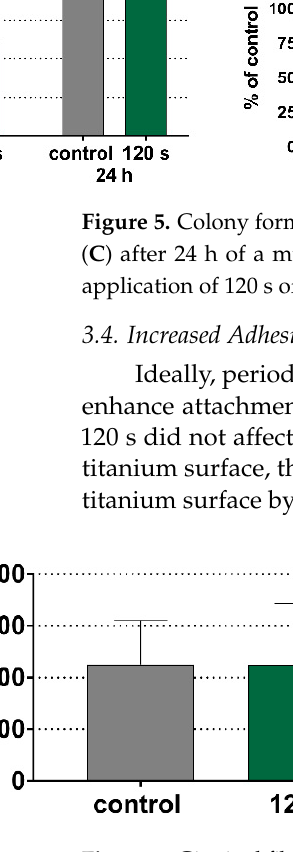
Figure 4. Colony forming units (CFU) counts ( A ) after 4 h and 24 h, mass ( B ), and metabolic activity ( C ) after 24 h of a multi-species biofilm formation on dentin specimens immediately after the appli- cation of 120 s of cold plasma .